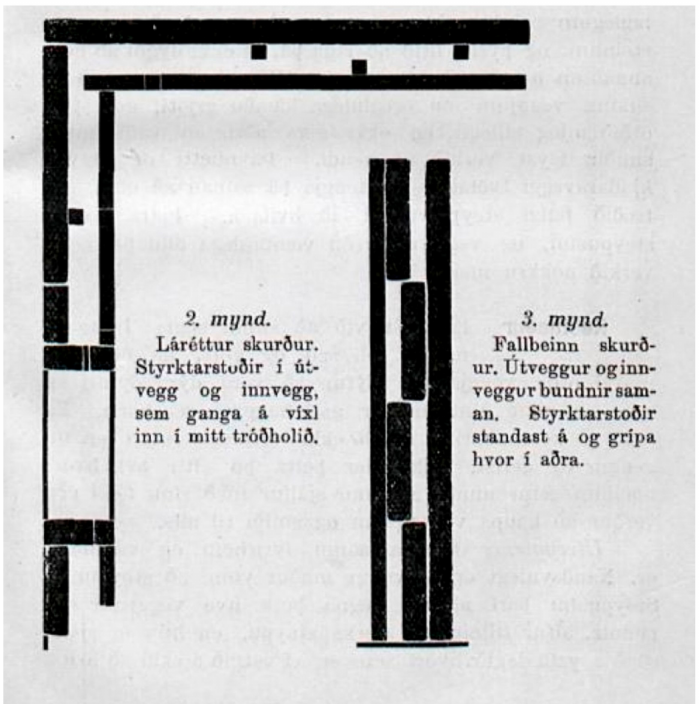
Figure 4. Guðmundur Hannesson, Hl ý og rakalaus steinh ú s, B ú naðarrit , Vol. 27, 1913. Sections of outer and inner walls showing different connections. Full article publicly available at t í marit.is.